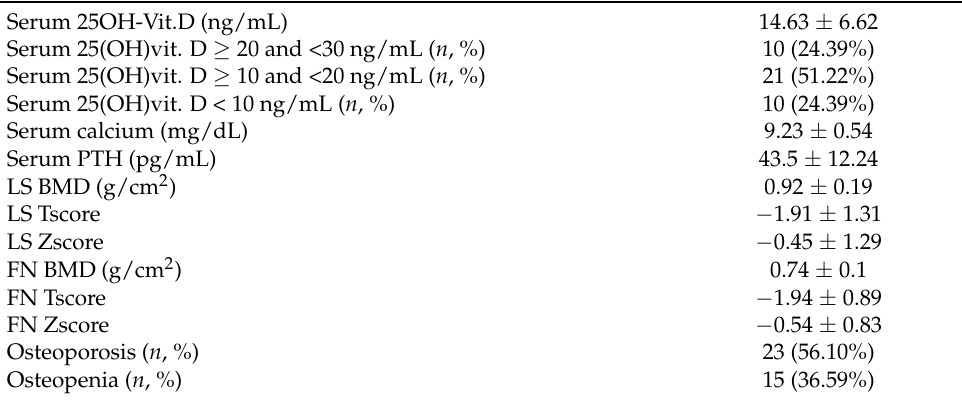
Table 2. Vitamin D status and bone health outcomes in the study population ( n = 41).